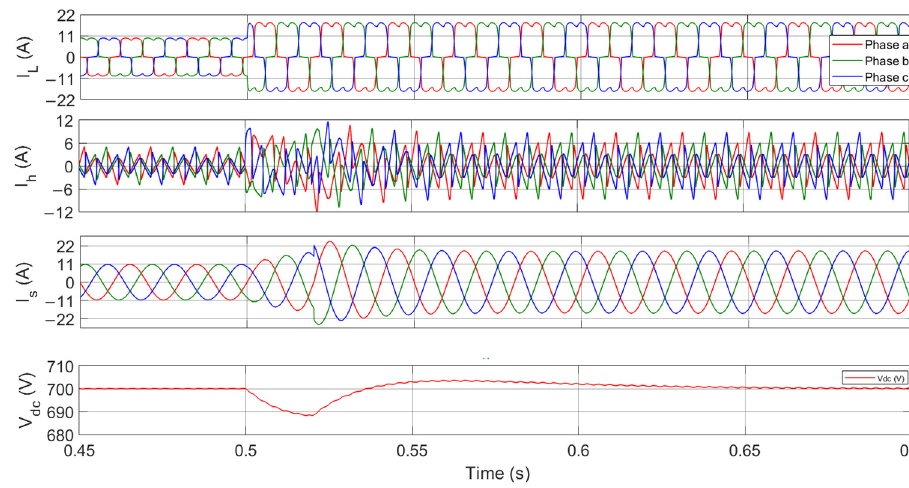
Figure 9. Waveforms and DC-link voltage during load change using MPM technique.